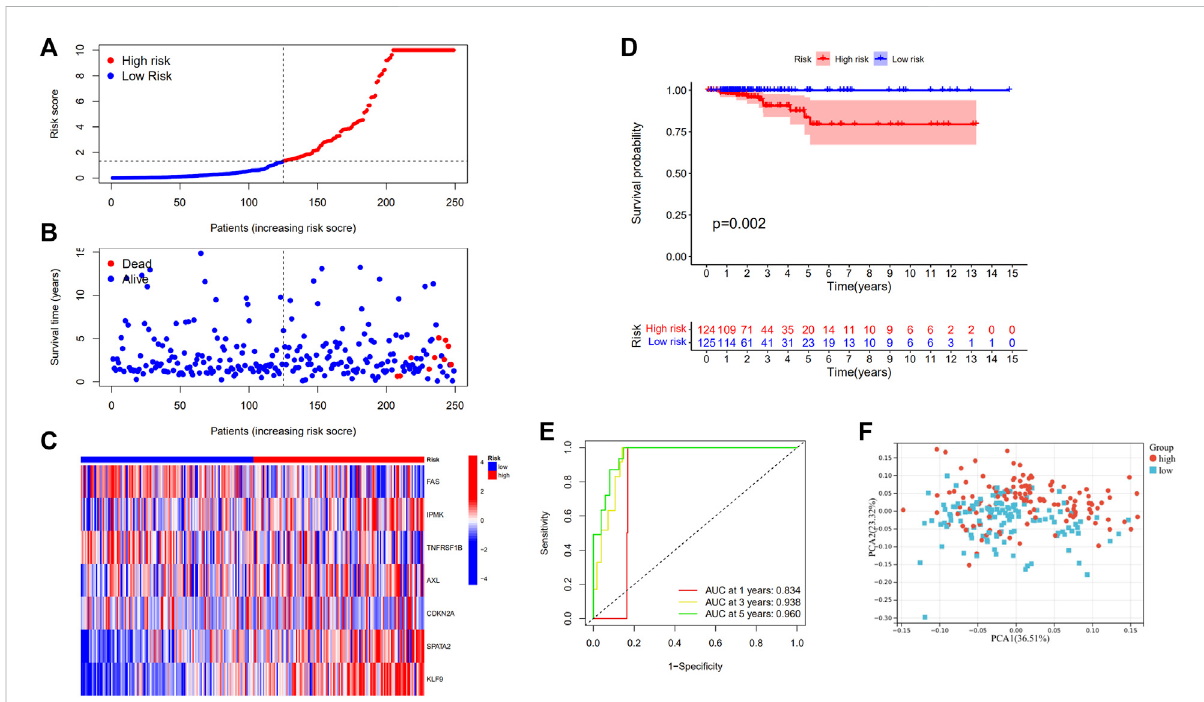
FIGURE 3 Construction of risk signature in the train set ( N = 249). (A) The distribution of risk score, (B) survival status, and (C) the expression of seven necroptosis-related genes in high- and low-risk groups; (D) Kaplan – Meier curves for OS of THCA patients in high- and low-risk groups; (E) Time- dependent ROC analysis, (F) PCA of TCGA cohort in the train